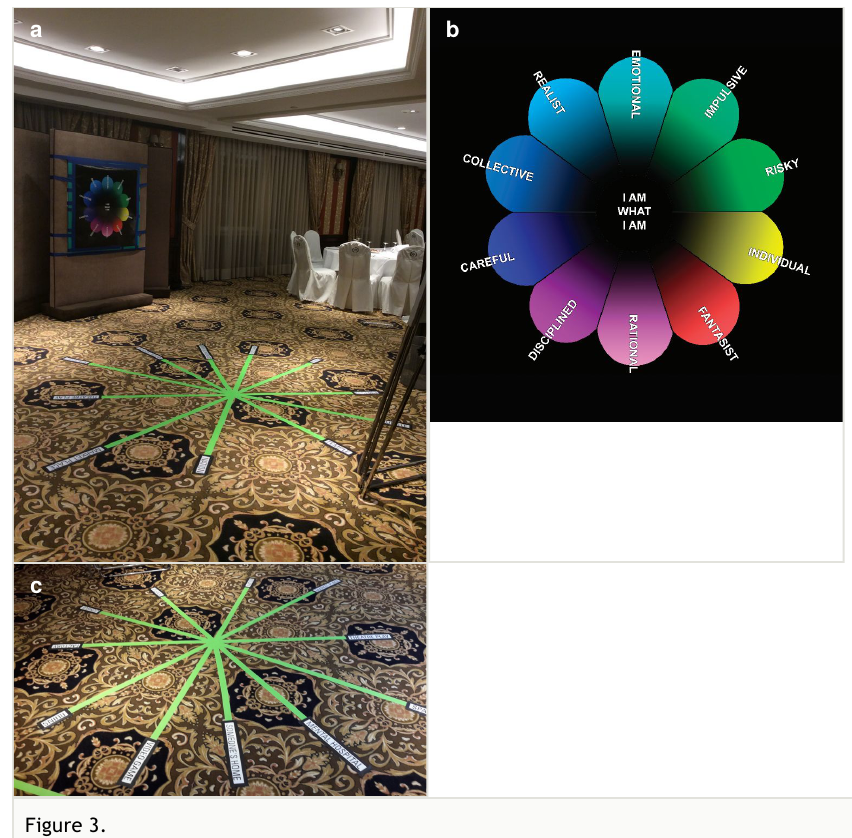
Figure 3. Islands of possibilities (part of YKON facilitation) at Madrid